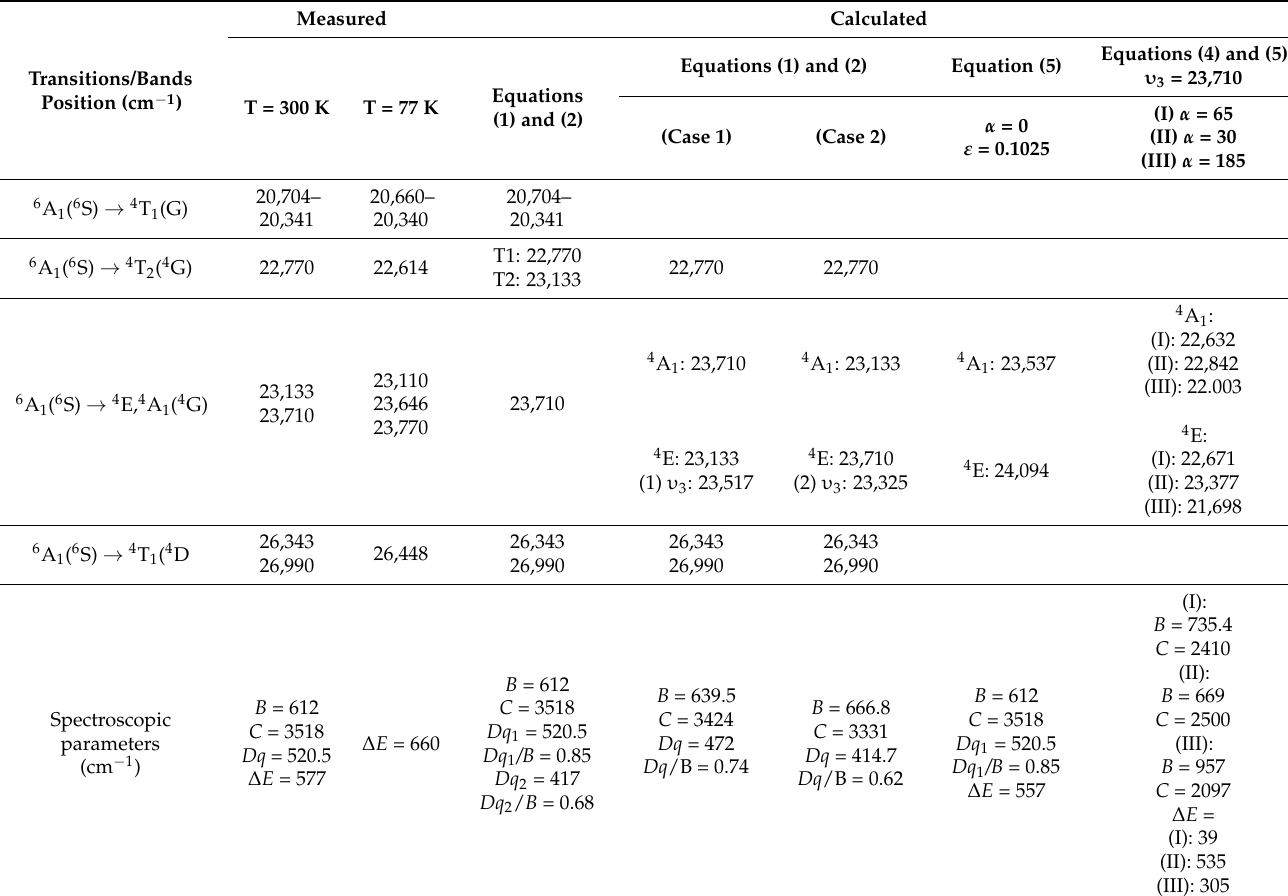
Table 9. The measured and calculated Mn 2+ -bands for willemite sample W2.